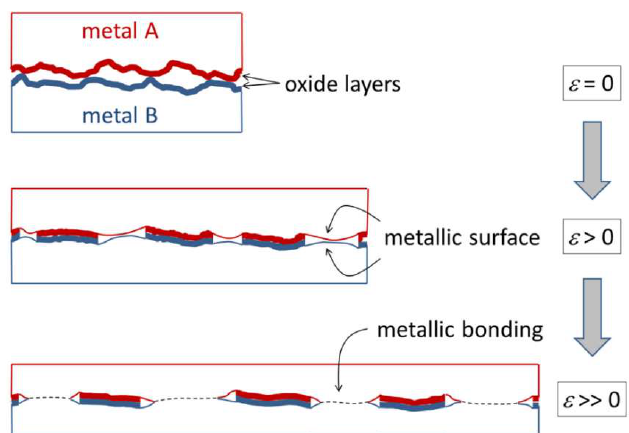
Figure 6. Schematics of interfacial plastic deformation resulting in cold welding. Under high strains, there is contact between fresh metallic surfaces and grain boundaries are formed between the two metals [29].